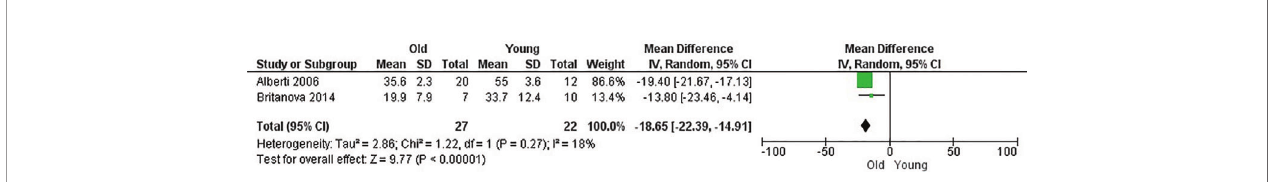
FIGURE 4 | In fl uence of age on naive CD8+ T cell frequency. Forest plot for the different outcomes regarding cell frequency between old and young groups. The forest plot displays the SMD (squares) and 95% con fi dence interval of the individual studies. The diamond in each plot indicates the overall estimate and 95% con fi dence interval.